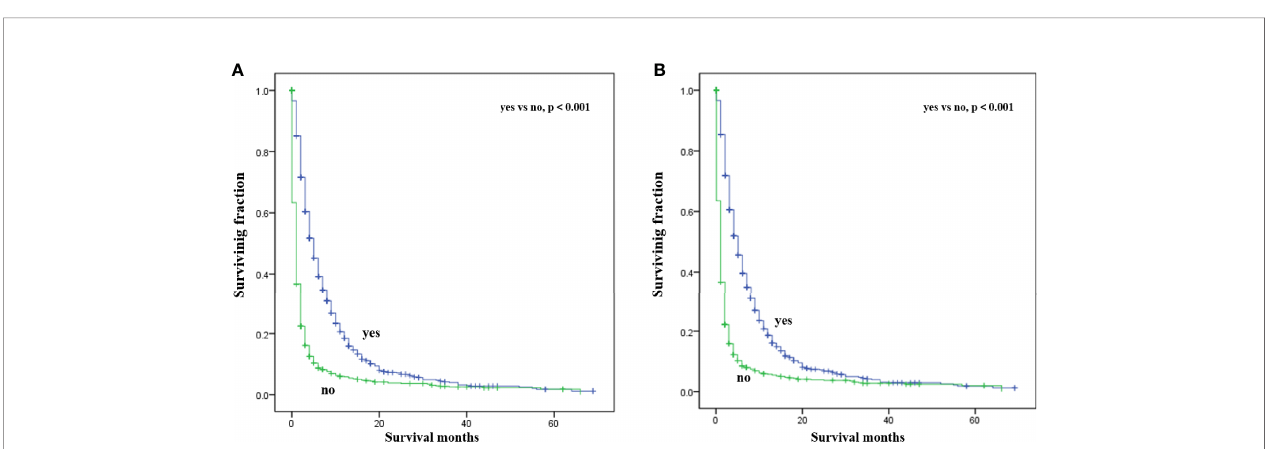
FIGURE 5 | Kaplan-Meier survival curves for estimating OS (A) and CSS (B) in patients with PCBM based on